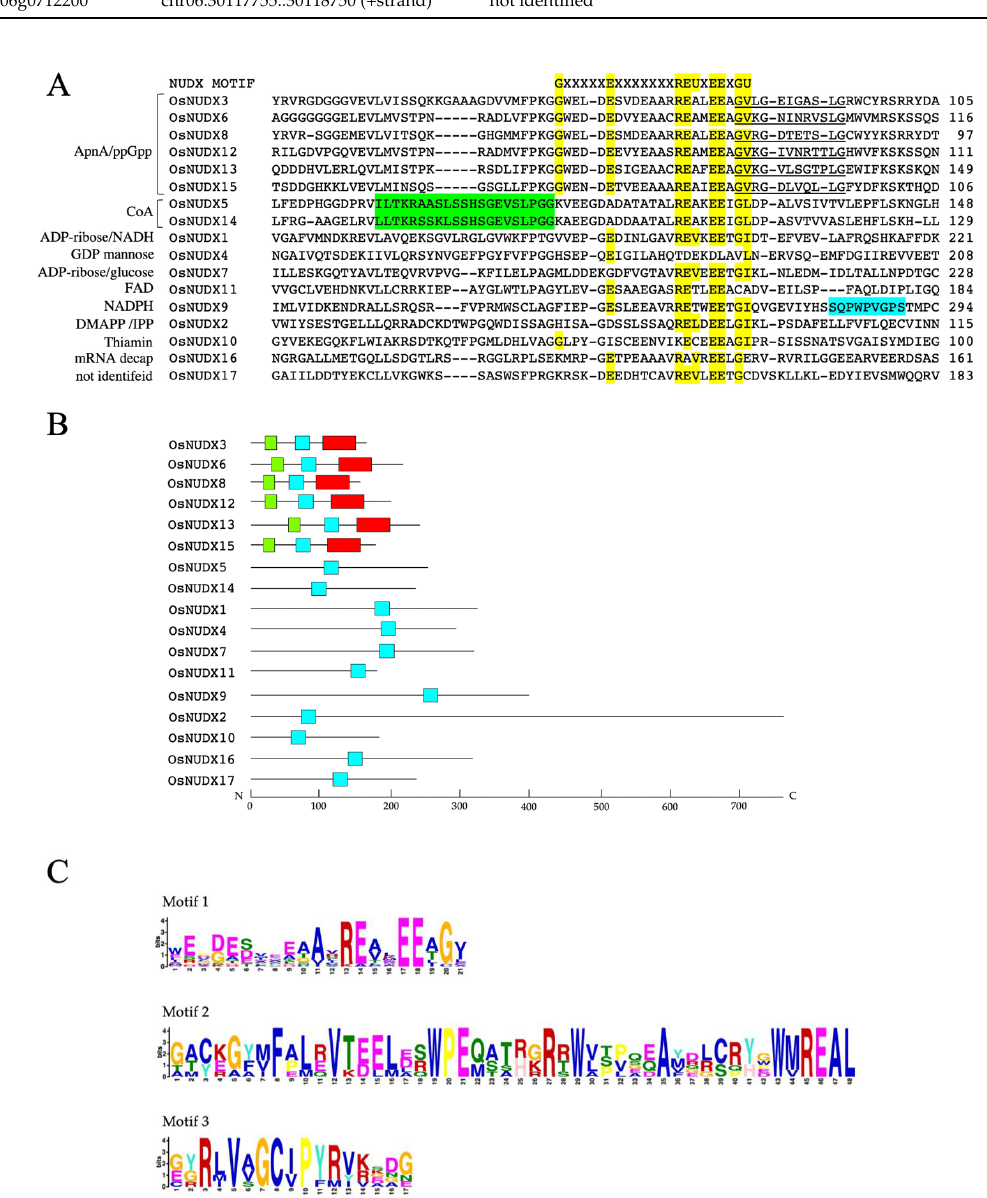
Figure 1. Alignment and conserved motifs of the amino acid sequences of the putative rice NUDXs. ( A ) Alignment was constructed by the CLUSTAL W program. Gaps, denoted by a dash, were intro- duced into the sequences to maximize the identity. The nudix motif is shown above the sequence. Identical amino acid residues to those of the nudix motif are shown as yellow boxes. The motifs of GX 2 GX 6 G in the ApnA/ppGpp NUDX, LLTXR[SA]X 3 RX 3 GX 3 FPGG in the CoA NUDX, and SQX 2 WPXPXS in the NADPH NUDX are shown, respectively, as underlined, green boxes, and blue boxes. The deduced subfamily is shown at the left side; ( B ) distribution of conserved motif 1 (blue boxes), motif 2 (red boxes), and motif 3 (green boxes) in the OsNUDXs predicted by the MEME program. The x-axis indicates the length of the amino acid residues from the N-terminal (N) to the